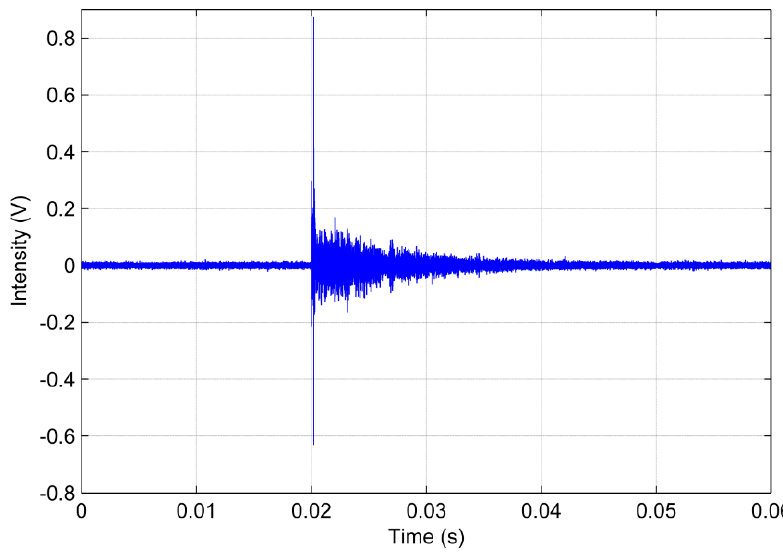
Figure 6. Partial discharge signal in the time domain obtained for the piezoelectric diaphragm.